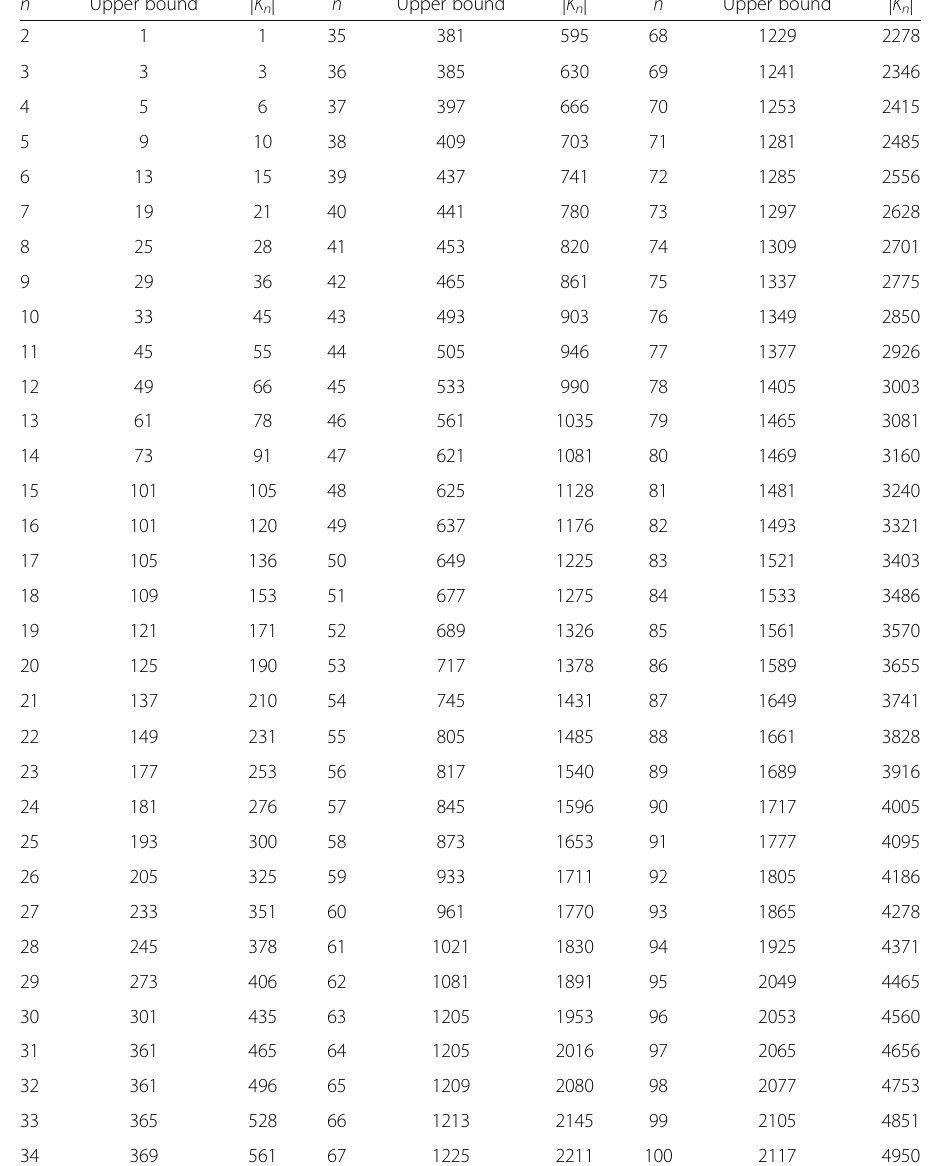
Table 1 The upper bound for the number of edges of a graph with n vertices